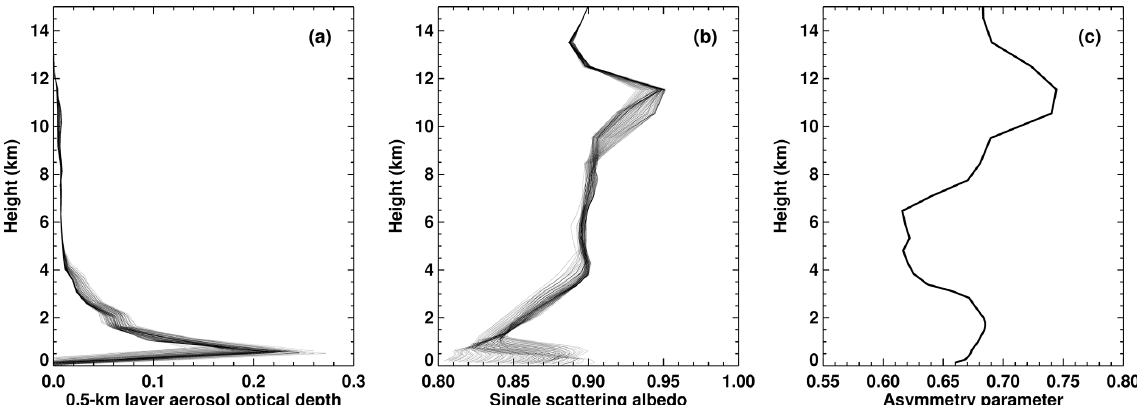
Figure 5. Vertical profiles of layer AOD (a) , single-scattering albedo (b) , and asymmetry parameter (c) for different OMI pixels within the selected region.